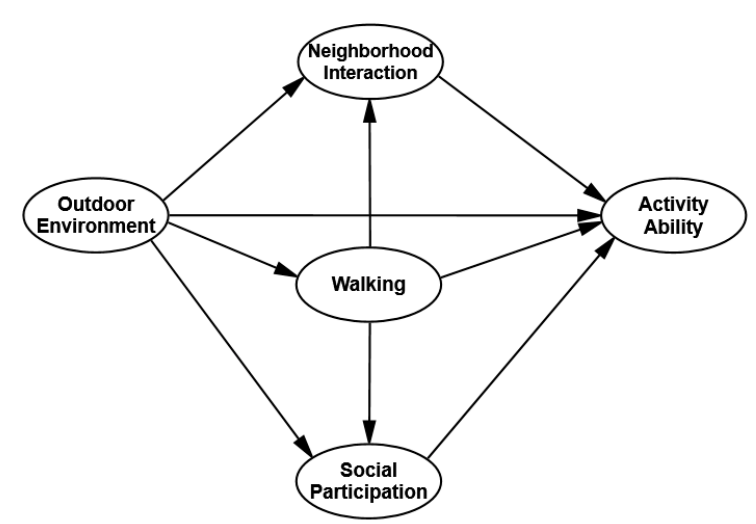
Figure 1. The hypothetical environment–behavior–activity ability model.